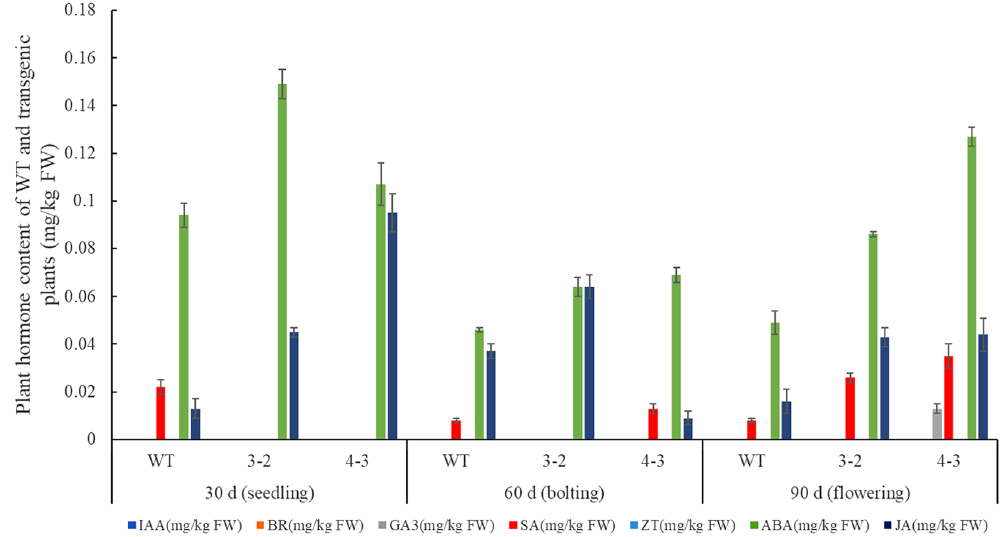
Figure 7. Plant hormone content of wild type and transgenic lines at different